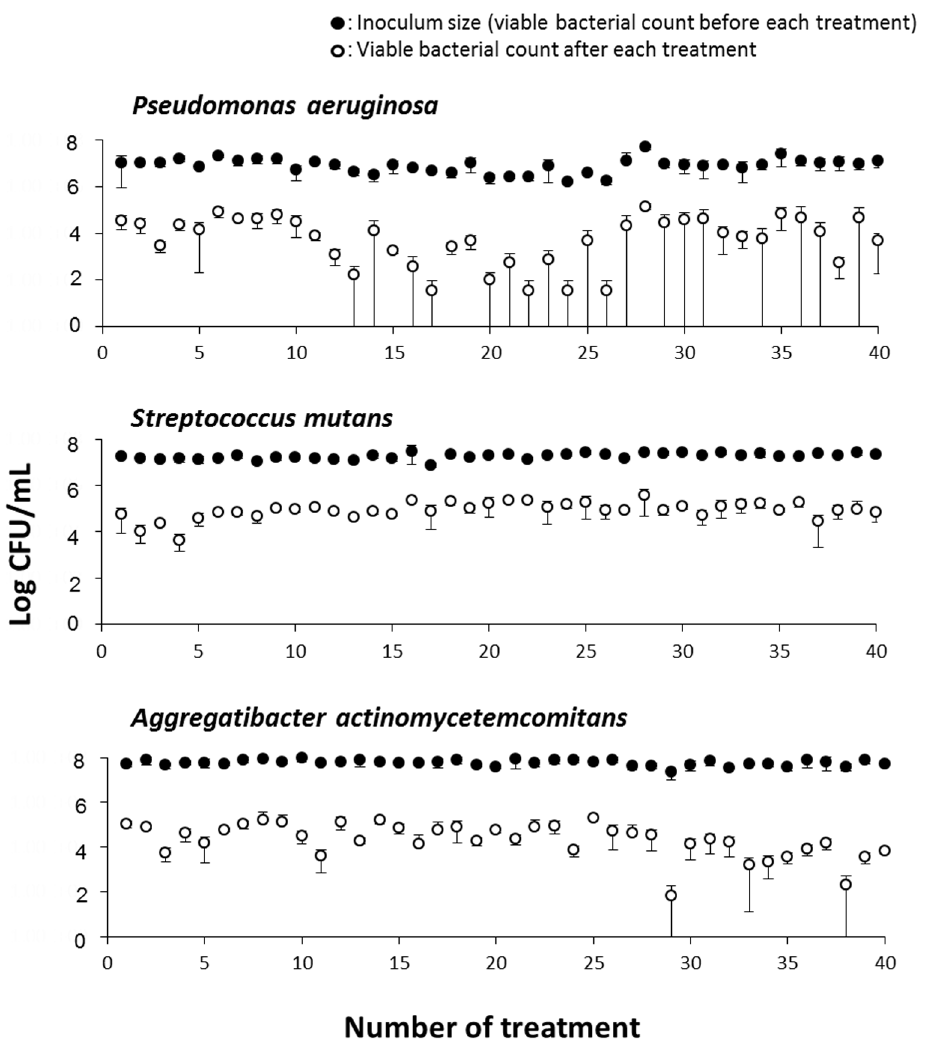
Figure 4. Changes in the antibacterial effect of disinfection treatment with photolysis of H 2 O 2 in three bacteria. Pseudomonas aeruginosa , Streptococcus mutans , and Aggregatibacter actinomycetemcomitans were exposed 40 times to disinfection treatment. Each value represents the mean 6 standard deviation (n=3).